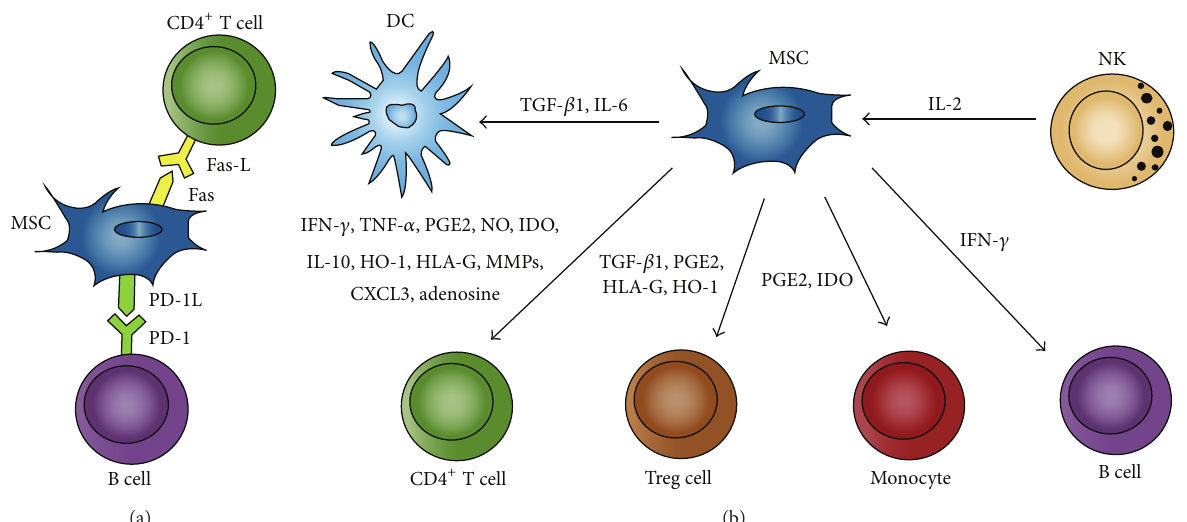
Figure 2: Mechanism of MSC modulation of immune cells. (a) Direct cell-cell contact, (b) soluble factors